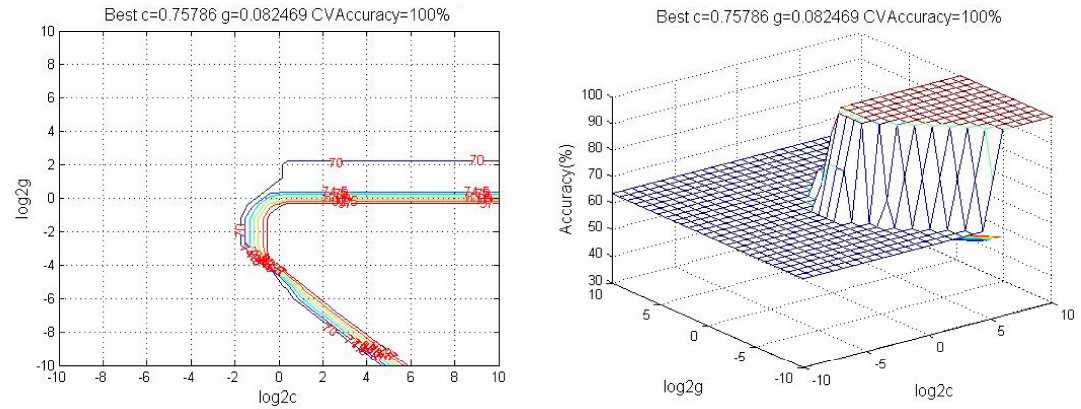
Figure 5. A 3D view of the SVM model of 21 biomarkers (The parameters are described below: Best c = 0.75786, g = 0.082469, CV accuracy = 100%, 112 × 86 mm (123 × 123 DPI).